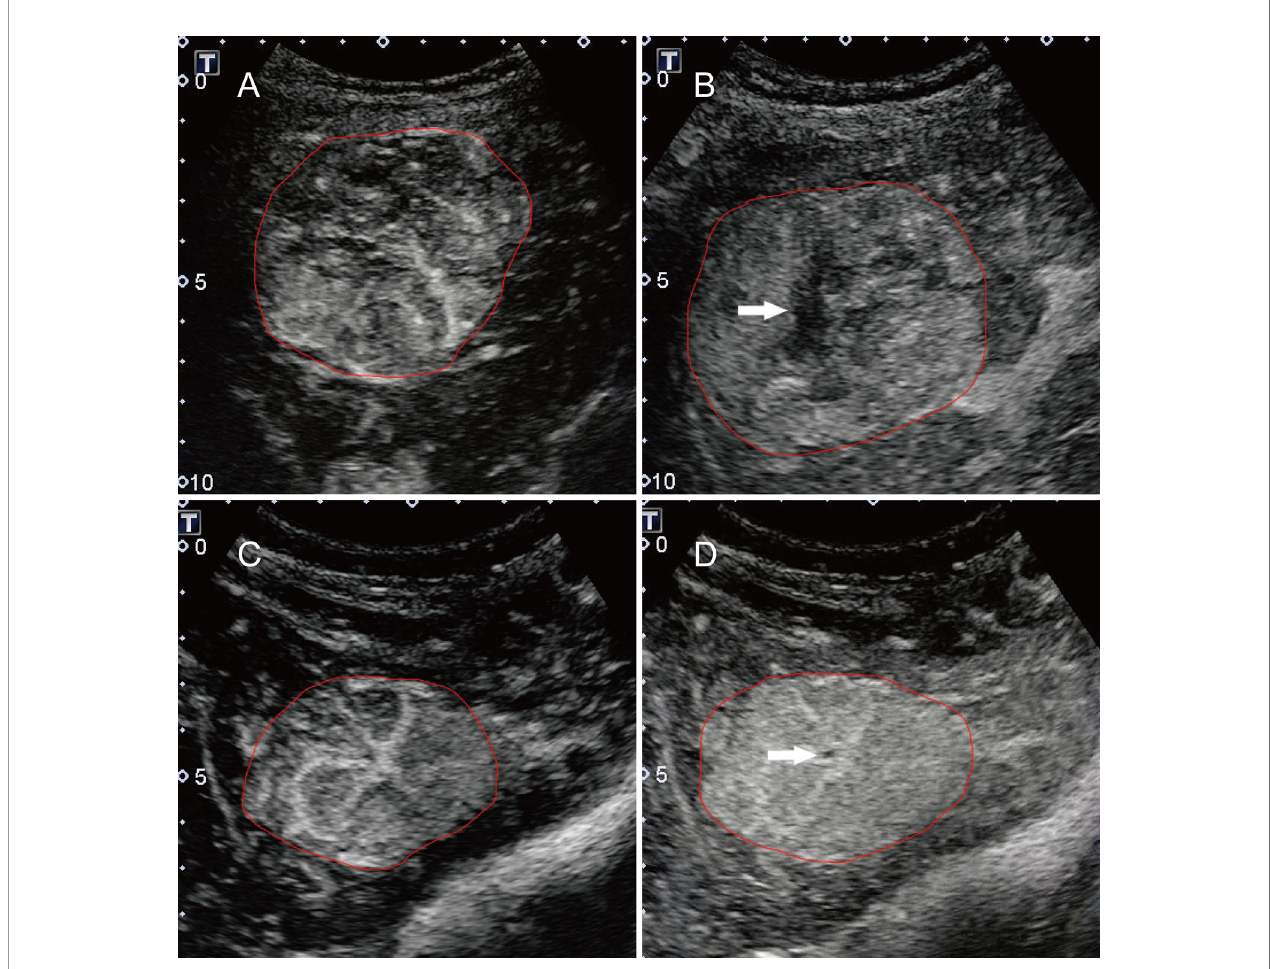
FIGURE 1 | Typical features for HCC and FNH lesions. (A) the basket pattern and/or chaotic vessels; (B) non-enhancing areas (arrow); (C) spoke-wheel arteries; and (D) unenhanced central scar (arrow). Annotations of the ROI generated by the radiologists around the tumor outline are delineated in